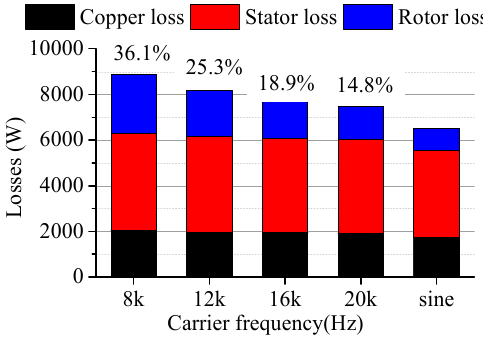
Figure 13. Influences of the carrier frequencies of the PWM inverter on the losses.